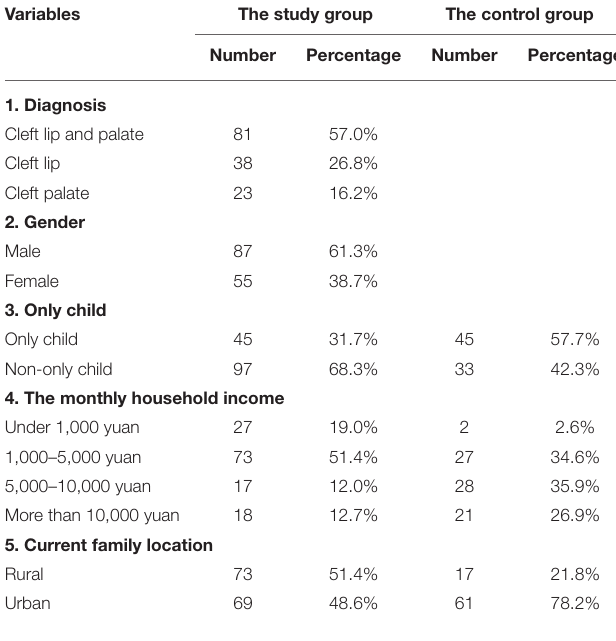
TABLE 1 | The demographic characteristics of the study group and control